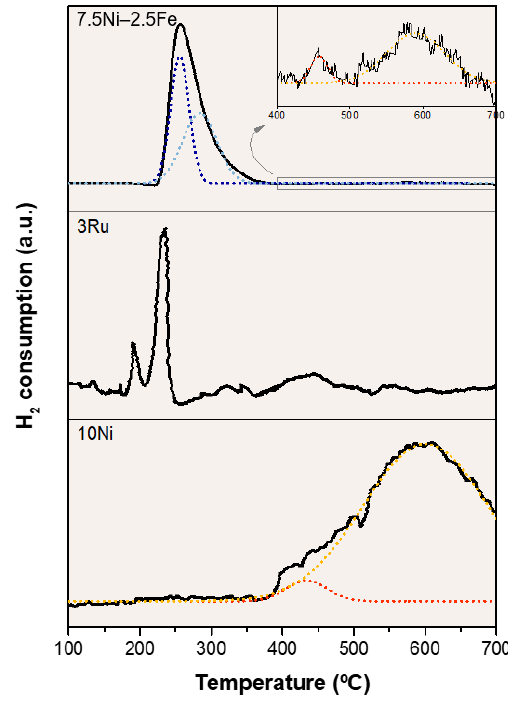
Figure 2. H 2 -TPR profiles for the three catalysts. Operating conditions: heating rate β = 2 ◦ C/min (from room temperature to 700 ◦ C), q 0 = 100 STPmL · min − 1 , v% H 2 = 5% (N 2 balance), and W cat = 0.1